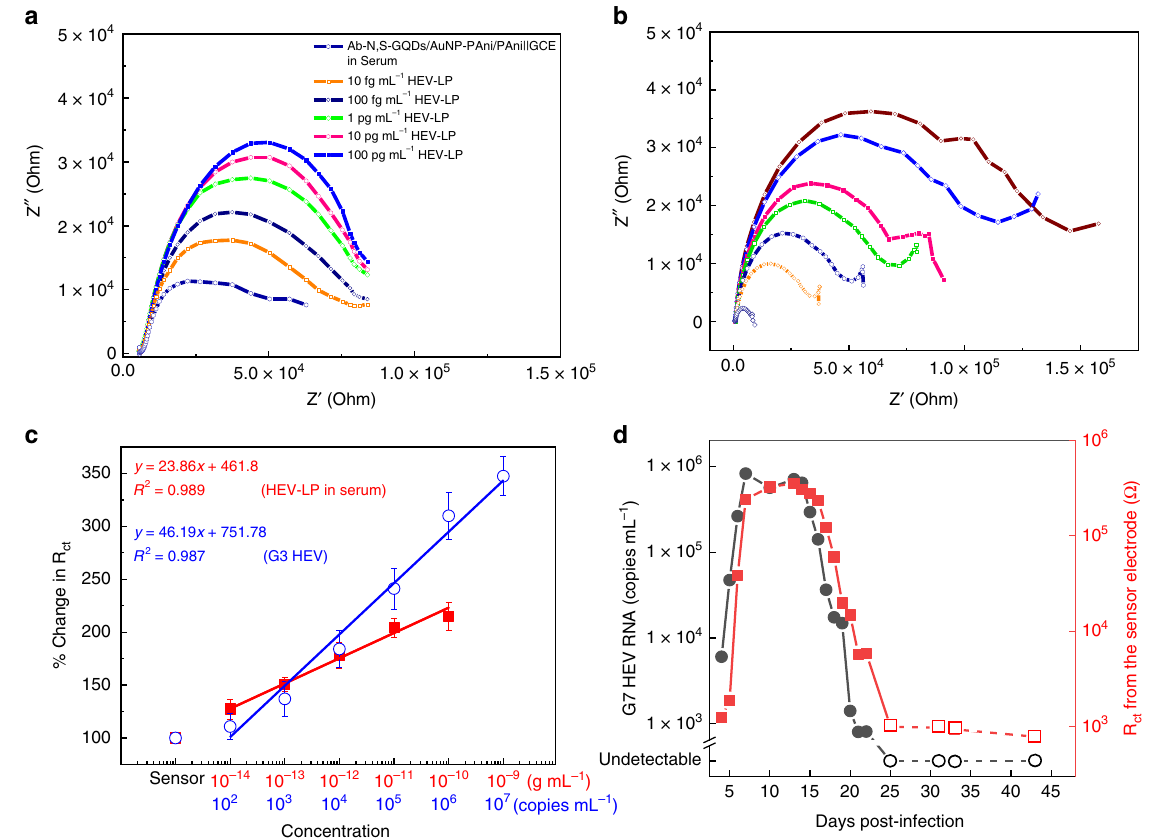
Fig. 7 Sensor performances in serum and different HEV analytes. Detection of HEV-LP in human serum ( a ) and G3 HEV in cell culture supernatants ( b ). c R ct vs. HEV for both cases of HEV-LP (closed squares) in serum and G3 HEV (open circles) in cell culture supernatants. Error bars represent the standard deviation of triple measurements. d Comparison of the sensitivity between the impedimetric sensor (closed squares) and RT-qPCR (closed circles) by detection of G7 HEV in fecal specimens. The fecal specimens were collected at 4 – 43 pdi from an experimentally G7 HEV-infected cynomolgus macaque monkey. Open circles represent samples in which the viral RNAs are undetectable by